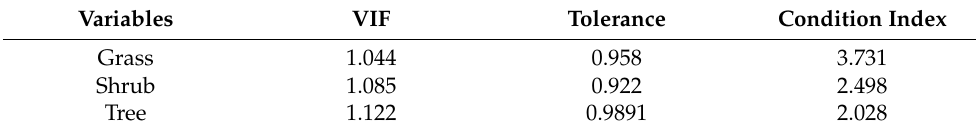
Table 2. Collinearity inspection of the influential factors.